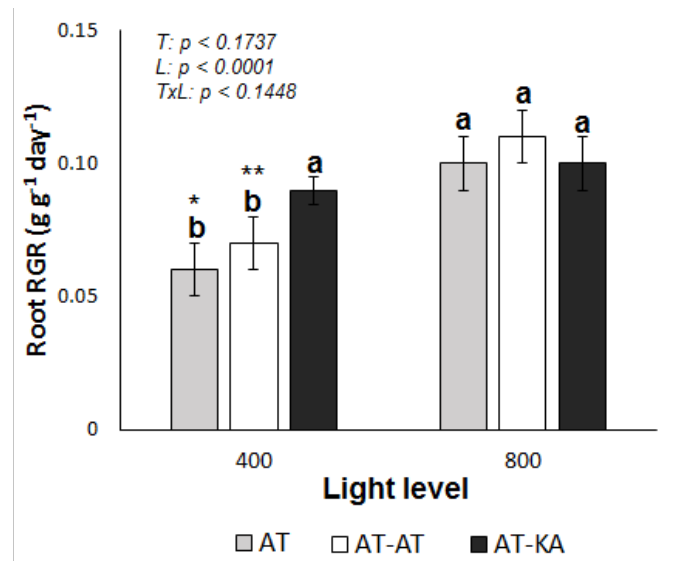
Figure 1. Shoot ( top ) and root ( bottom ) relative growth rate (RGR) in each treatment under medium (400 µ mol m − 2 s − 1 ) or high (800 µ mol m − 2 s − 1 ) light levels during a 30-day growth period. Bars represent mean ± SE of eight replicates. p -Values for treatment ( T ), light ( L ) and the interaction ( TxL ) effects are included in each case. Different letters denote significant differences ( p < 0.05) among treatments within each light level. Asterisks indicate the significance level (*: p < 0.05; **: p < 0.01; ***: p < 0.0001) for the differences in the same treatment across light levels. AT: Non-grafted treatment; AT-AT: Homograft; and, AT-KA: Graft treatment.